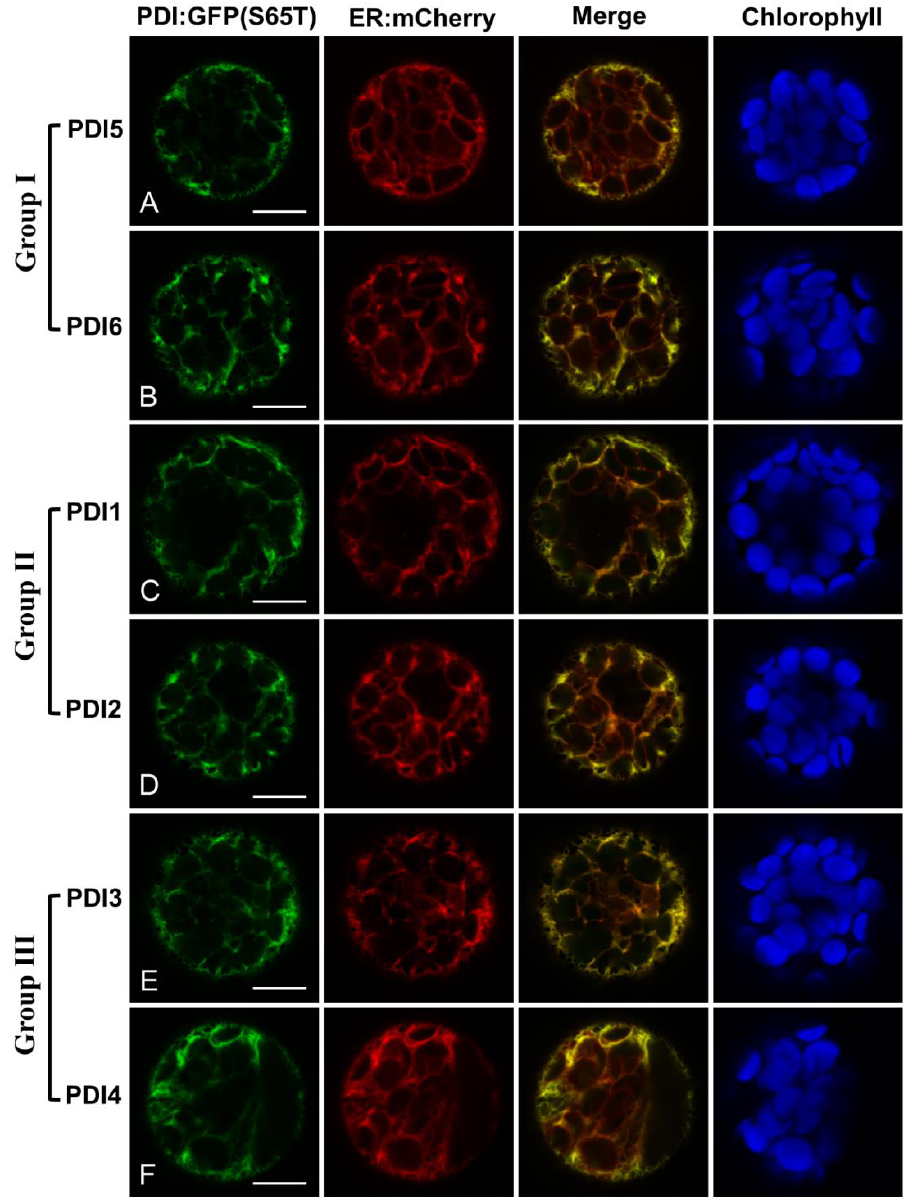
Figure 2. Arabidopsis PDIA1 homologs fused to GFP localize to the ER. ( A ) ( E ) PDI3:GFP-KDEL; ( F ) PDI4:GFP-KDEL. Each chimeric fusion was co-expressed